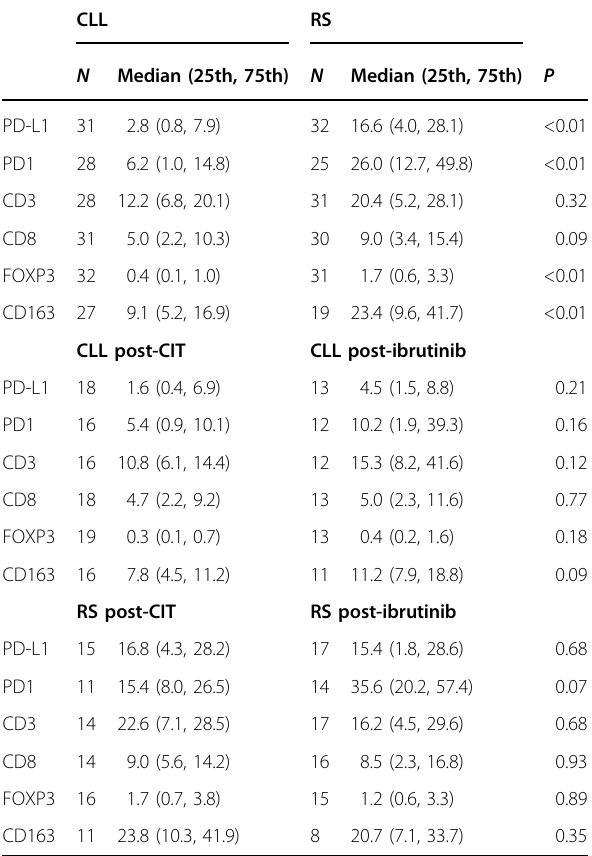
peripheral blood. Patients with RS had a lower peripheral blood T-cell TCR clonality and more diverse T-cell